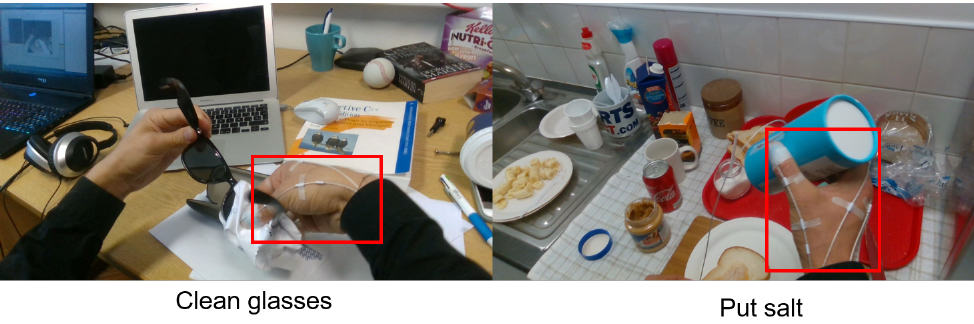
Figure 2. Illustration of obscured fingers in the FPHAB dataset